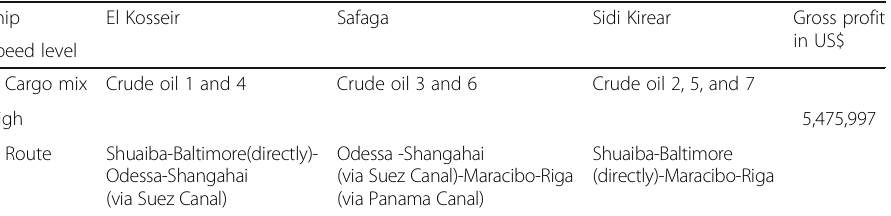
Table 8 Cargo mix, route, and gross profit reported by the model (with gross profit objective) for each ship, at high speed